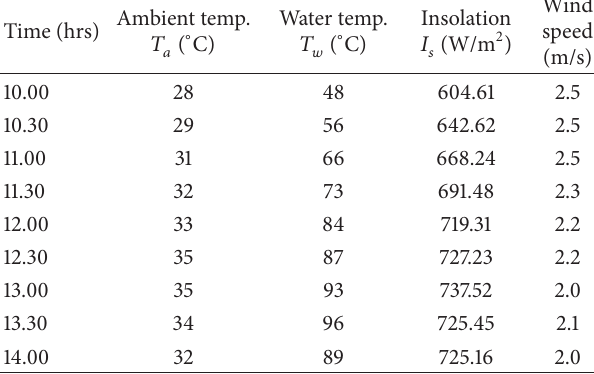
Table 1: Stagnation temperature test ( 𝐹 1 ) (03/03/2013) . Plate temp. Ambient temp. Time (hrs) ∘ C) ∘ C) 𝑇 𝑇 𝑝 ( 𝑎 (